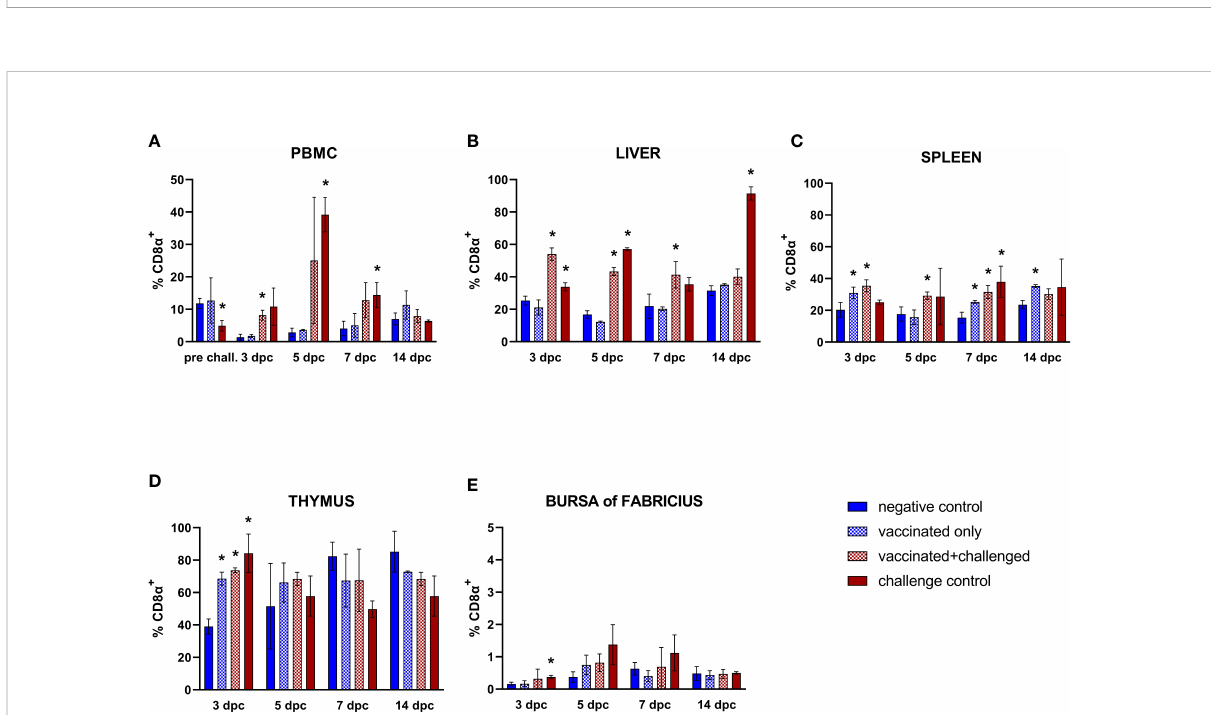
FIGURE 6 Relative number of CD8 a + T lymphocytes within total CD45 + cells measured via FCM for each experimental group throughout the study in PBMC (A) , liver (B) , spleen (C) , thymus (D) , and bursa of Fabricius (E) . Data for the two vaccinated groups (vaccinated only and vaccinated+challenged) are merged to determine values in PBMCs pre-challenge. Asterisks represent signi fi cant difference compared to the negative control at each time point ( p ≤